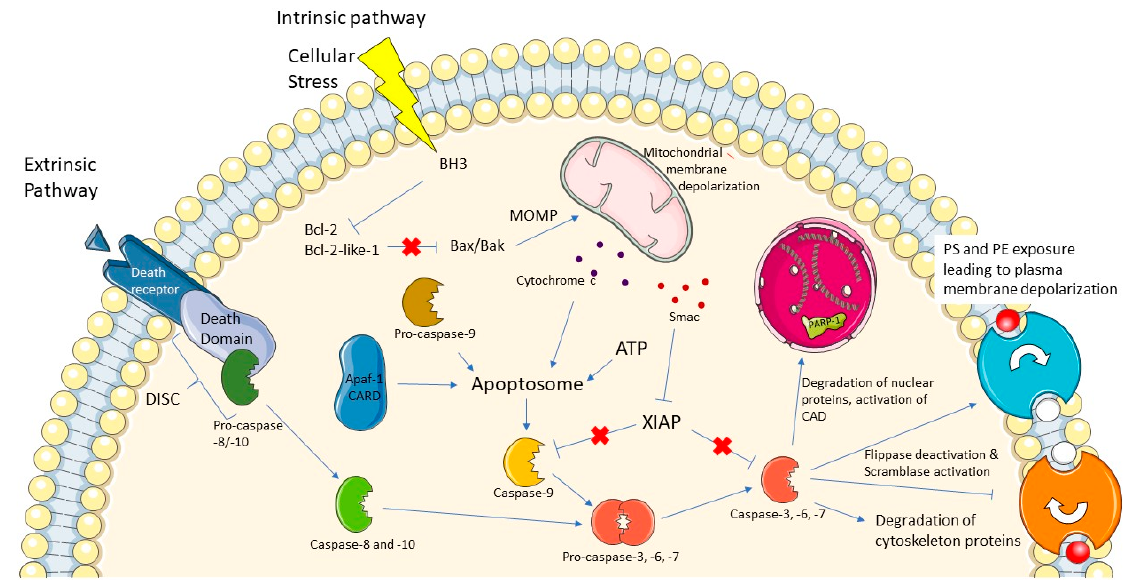
Figure 1. Mechanisms of apoptosis. In the extrinsic pathway, death receptors are activated, leading to the activation of the initiator caspase-8 and -10. In the intrinsic pathway, cellular stress leads to the activation of Bcl-2 homology 3 (BH3)-only proteins, which disable the antiapoptotic proteins Bcl-2 and Bcl-2-like-1 that normally inhibit Bax and Bak proteins. This results in the permeabilization of the mitochondrial membrane, causing mitochondrial membrane depolarization and the release of cytochrome c and Smac proteins. Cytochrome c induces the formation of the apoptosome, followed by the activation of the initiator caspase-9. In both pathways, initiator caspases activate effector caspases, starting the degradation of intracellular material and the death of the cell.